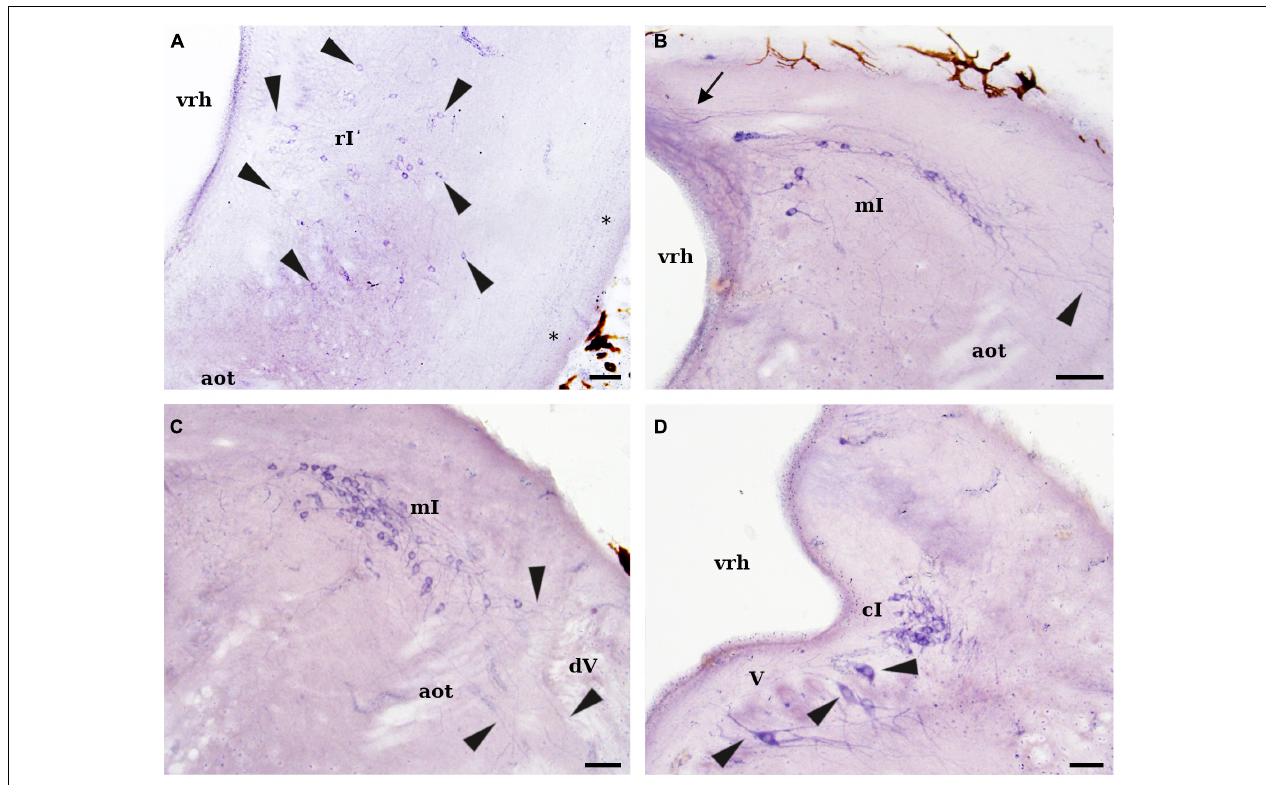
FIGURE 6 | Photomicrographs showing NADPH-d positive cells and fibers in the isthmic region of L. fluviatilis . (A) Transverse section showing NADPH-d labeled cells (arrowheads) in the rostral isthmic region (rI). These cells distribute in a wide area of the isthmic tegmentum. Note also a labeled tract coursing in the lateral margin of the tegmentum (asterisks). (B) Transverse section showing NADPH-d positive cells in the medial isthmic region (mI). Processes of these cells are seen coursing to the contralateral side (through the so-called cerebellar commissure; arrow) or ramifying in the lateral part of the brain (arrowhead). (C) Transverse section of the caudal part of the same nucleus (mI) showing lateral dendrites ramifying close to the entrance of the trigeminal nerve roots (arrowheads). Thick unlabeled axons of the anterior octavomotor tract (aot) can be also identified. (D) Transverse section showing NADPH-d positive cells of the caudal isthmic nucleus (cI) located at pretrigeminal level. Note also the presence of some clearly positive cells in the trigeminal motor nucleus (V; arrowheads). Medial direction is oriented to the left in all transverse sections. For abbreviations, see list. Scale bar = 25 µ